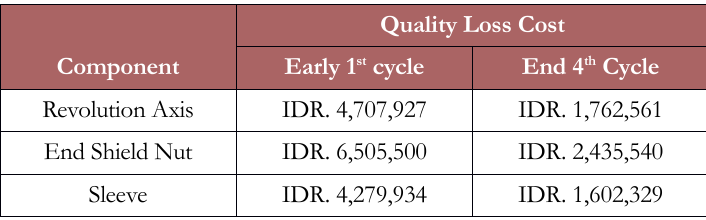
Table 15. Reduction of quality loss in supplier side